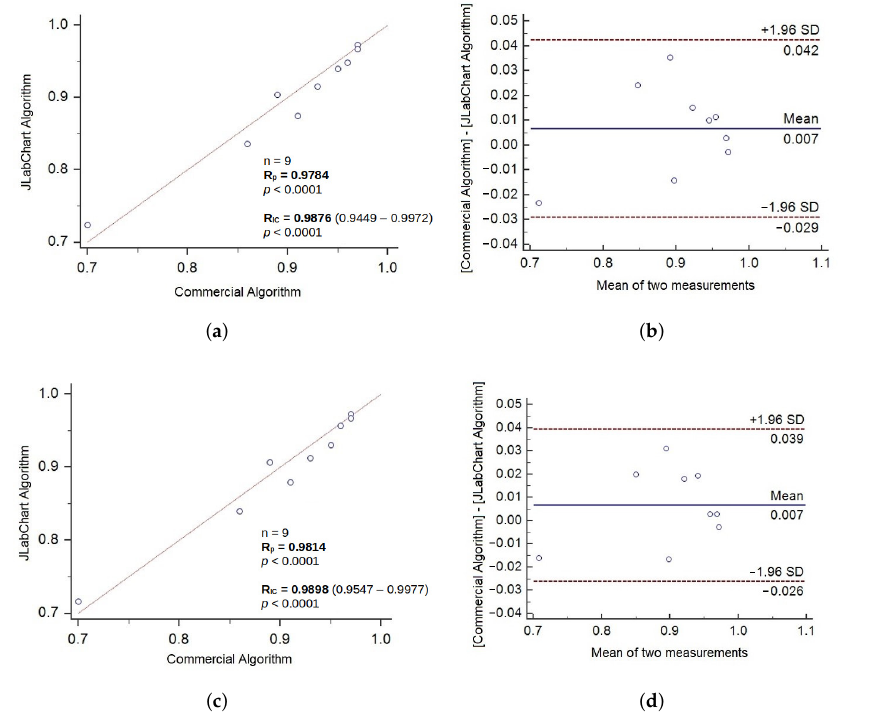
Figure 12. Correlation plot and Bland–Altman for iFR and iFR*. ( a ) Correlation plot for iFR. ( b ) Bland–Altman plot for iFR. ( c ) Correlation plot for iFR*. ( d ) Bland–Altman plot for